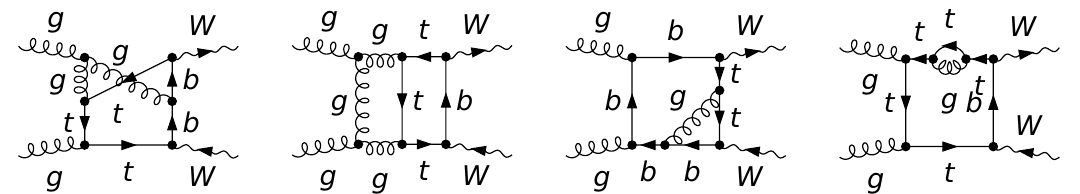
Figure 1. Representative two-loop Feynman diagrams for gg → WW .